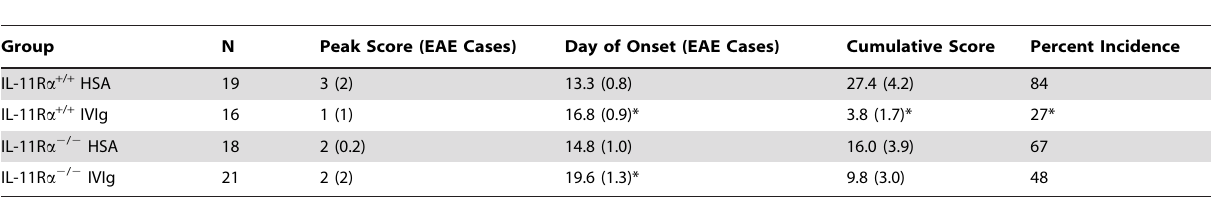
Group N Peak Score (EAE Cases) Day of Onset (EAE